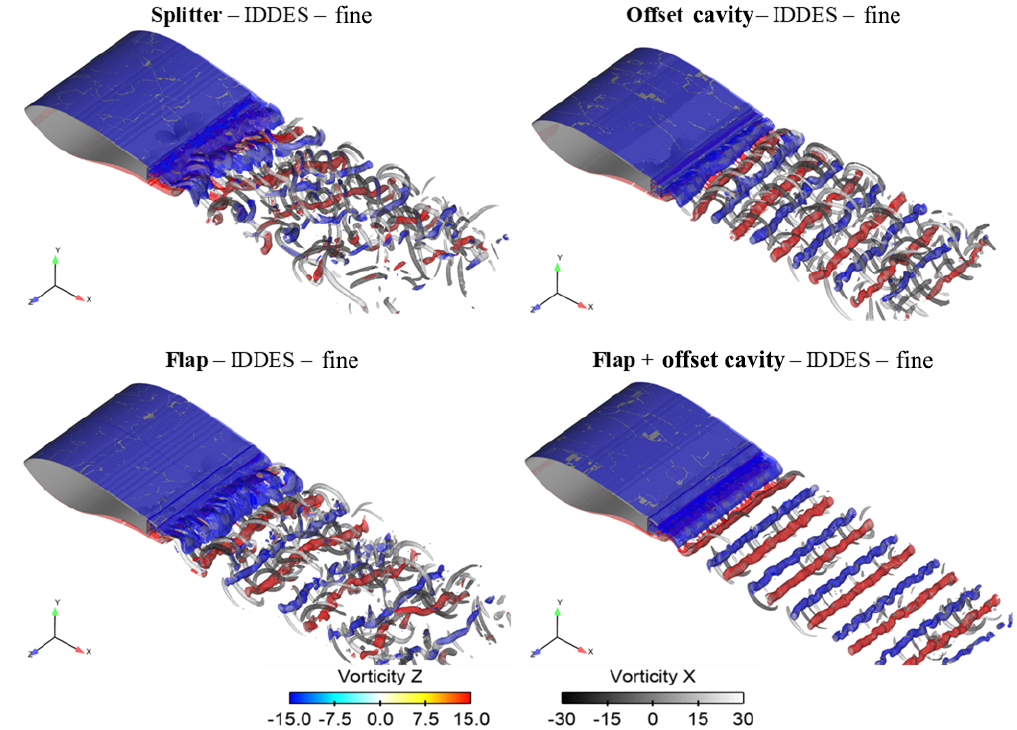
Figure 14. Instantaneous isosurfaces of (cid:49) = 10 5 coloured by streamwise vorticity and overlaid instantaneous isosurfaces of spanwise vorticity ( ω z = ± 15). IDDES results on the fine